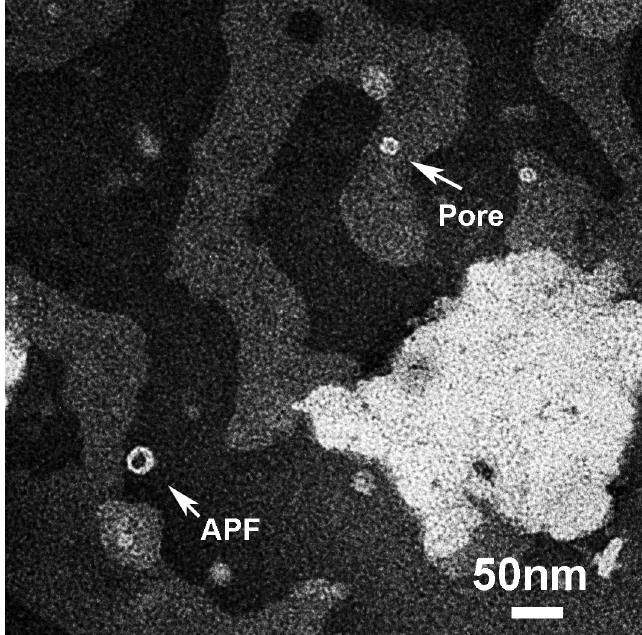
Figure 8. Energy-filtered (EF)-TEM images showing liposomes (gray) incorporating GM1 and Chol mimicking “lipid-rafts”, collapsed onto the amorphous carbon substrate (black). Small and geometrically ordered pore-like structures (white) can be observed in liposomes together with annular protofibrils (APFs) located outside.